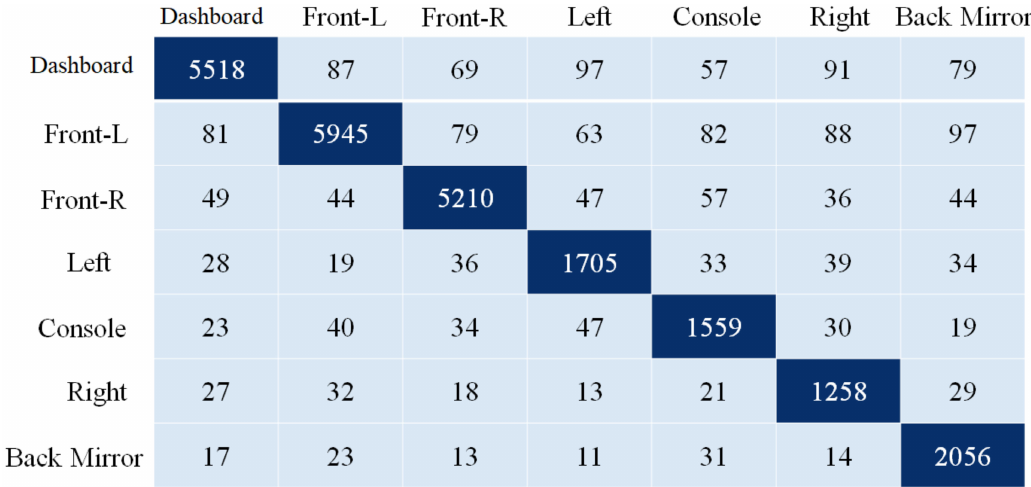
Figure 12. Training and validation loss plot of the gaze detection technique.